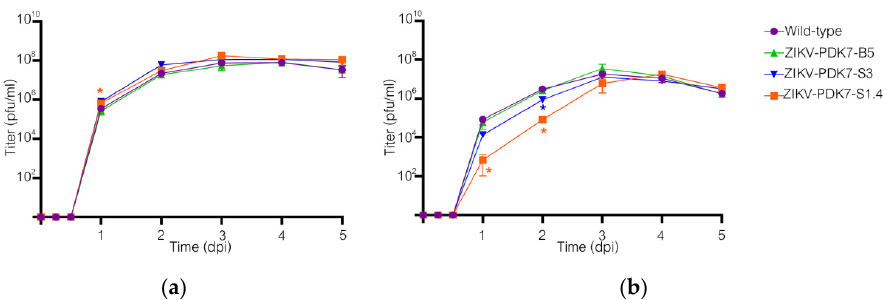
Figure 5. Growth kinetics of wild-type and ZIKV variants. Viral growth kinetics were determined in C6/36 ( a ) and Vero ( b ) cells. The cells were infected with ZIKVs; wild-type (circle), ZIKV-PDK7-B5 (triangle), ZIKV-PDK7-S3 (inverted triangle), and ZIKV-PDK7-S1.4 (square) at an MOI of 0.01. The experiment was performed in triplicate with duplicate plaque counting. The mean viral titers at each time-point were plotted with the error bar representing the standard deviation (SD). Two- way ANOVA was used to statistically analyze the data against the wild-type strain. Asterisks (*) indicate a statistically significant difference ( p < 0.05). If not displayed, the data did not show significant differences.